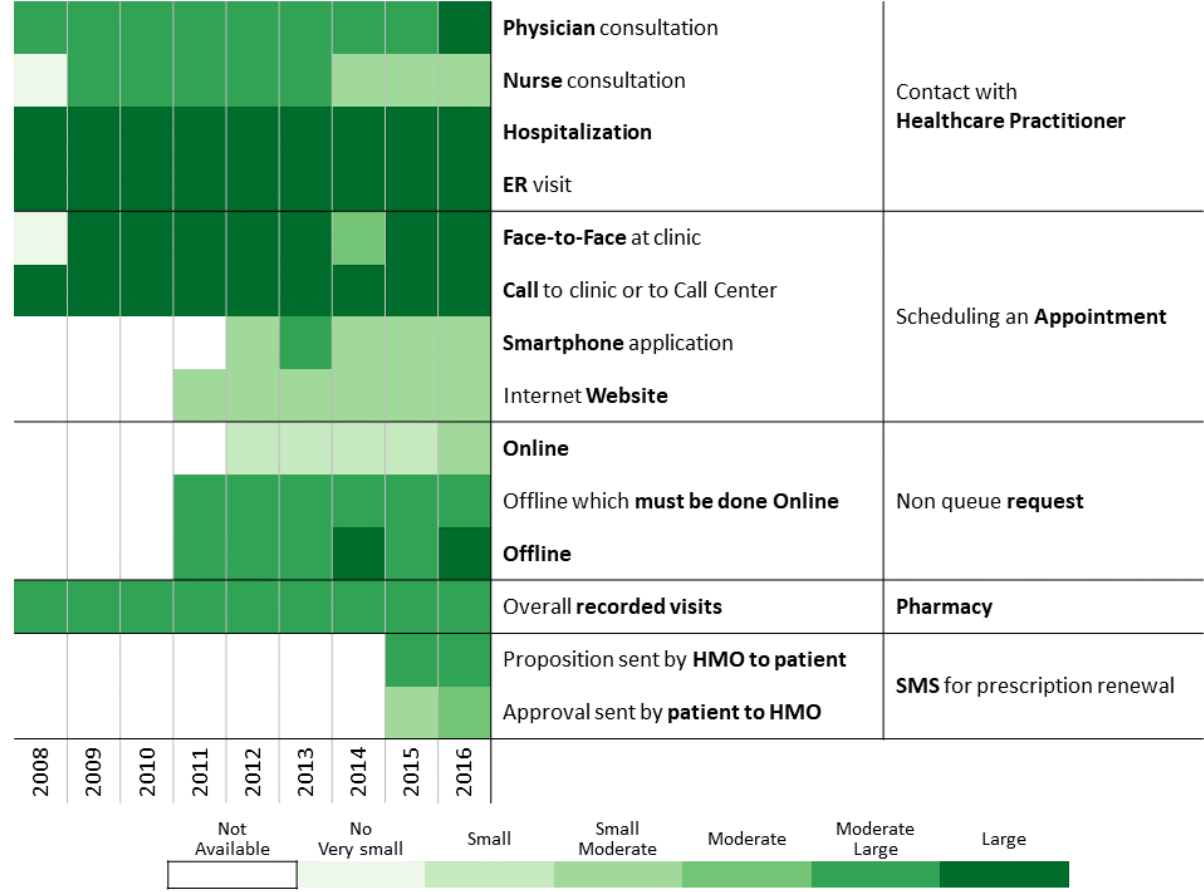
Figure 17. Communication pattern changes between 2008 and 2016 for patients with diabetes having mainly human-based contacts based on interactions with